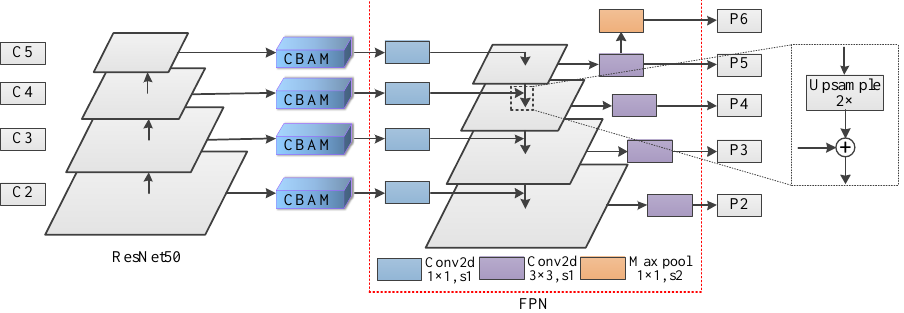
Figure 4. The structure of Feature Pyramid Network